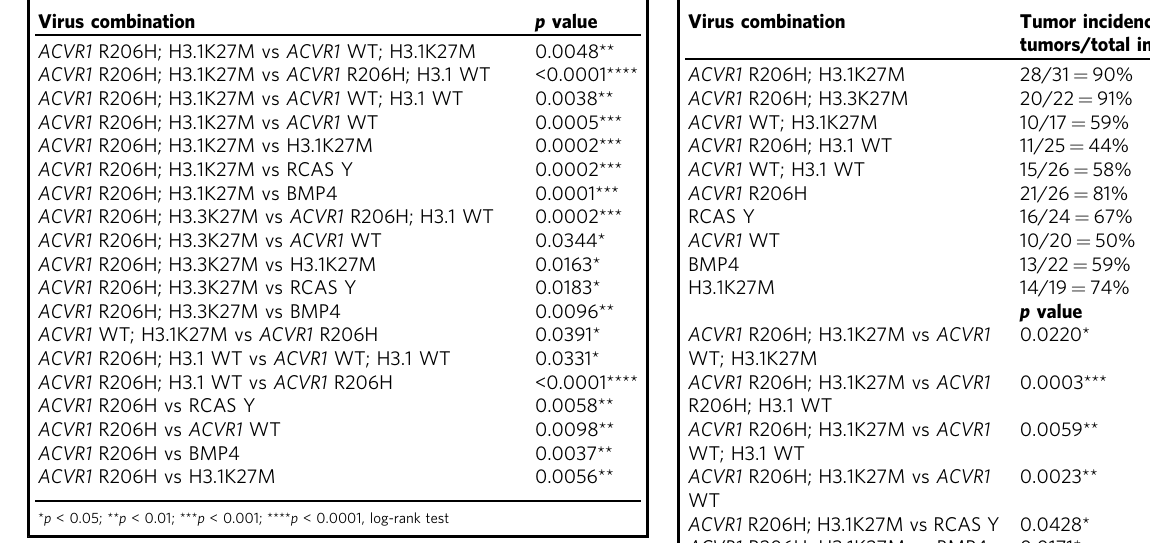
Table 1 ACVR1 R206H and H3.1K27M signi fi cantly decrease survival Virus combination p value